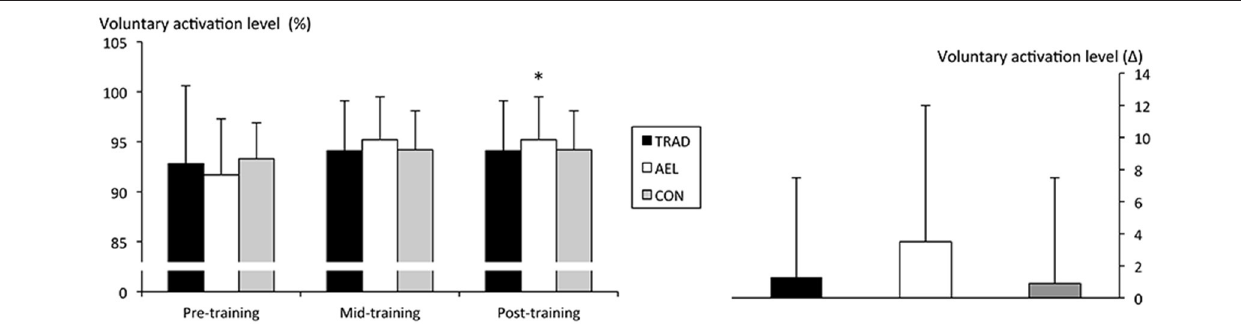
Frontiers in Physiology |